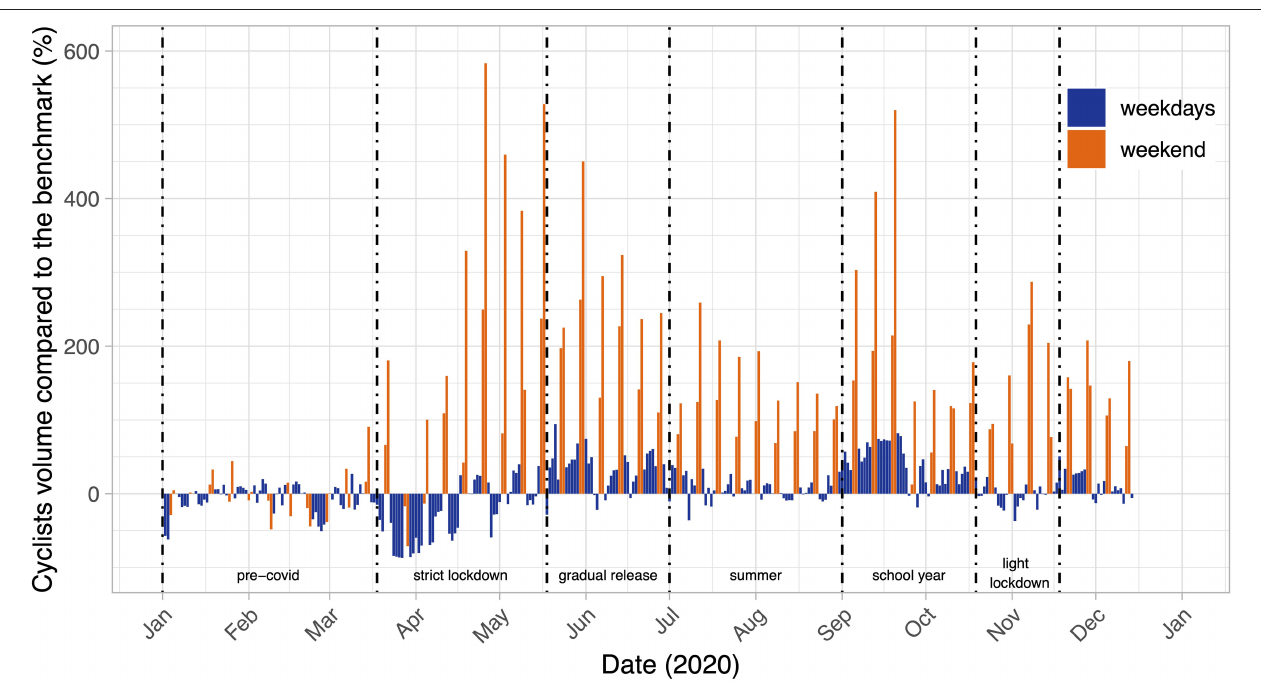
FIGURE 7 | Evolution in bicycle traffic in the Brussels Capital region in 2020 compared to the pre-lockdown benchmark (data source: Brussels Mobility).